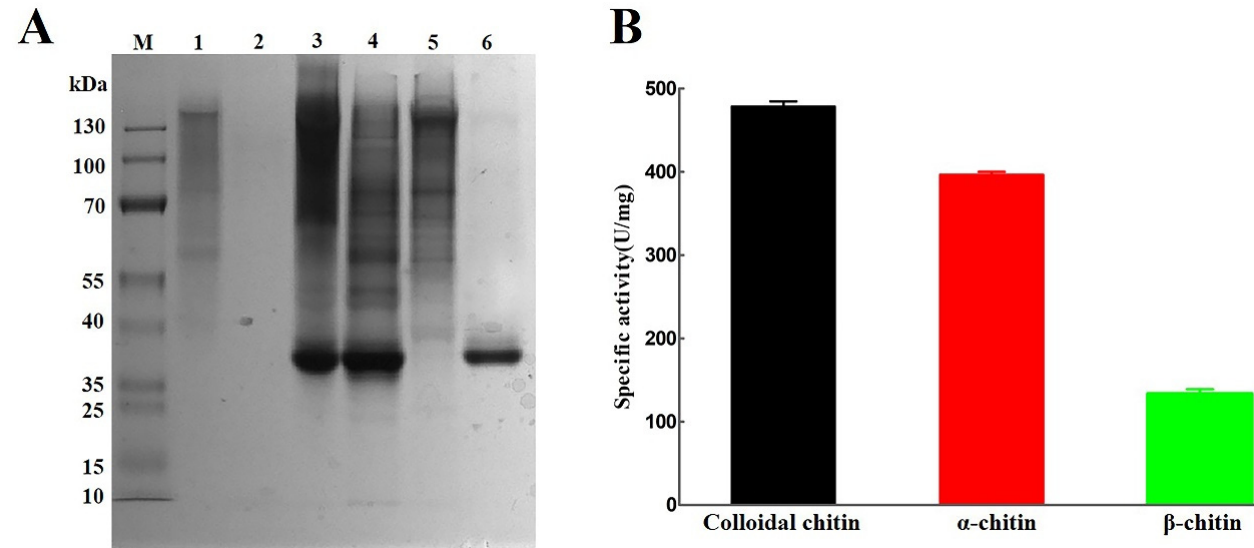
Figure 4. Purification and characterization of the recombinant protein As CDA from Acinetobacter schindleri MCDA01: ( A ) heterologous expression and purification of As CDA were analyzed by SDS- PAGE on a 12% gel after Coomassie brilliant blue R-250 staining; ( B ) specific activity of purified As CDA to colloidal chitin, α -chitin, and β -chitin. Lane M, proteins marker with standard molecular Masses; lane 1, negative control (empty vector pET-28a); lane 2, Fermentation supernatant from Escherichia coli BL21 containing expression vector pET28a-AsCDA induced with IPTG; lane 3, insoluble phase of cellular extracts from Escherichia coli BL21 containing expression vector pET28a- AsCDA induced with IPTG; lane 4, soluble phase of cellular extracts from Escherichia coli BL21 containing expression vector pET28a-AsCDA induced with IPTG; lane 5, effluent fractions when all proteins were washed clean with elution 80 mM imidazole conc; lane 6, purified As CDA with elution 300 mM imidazole.